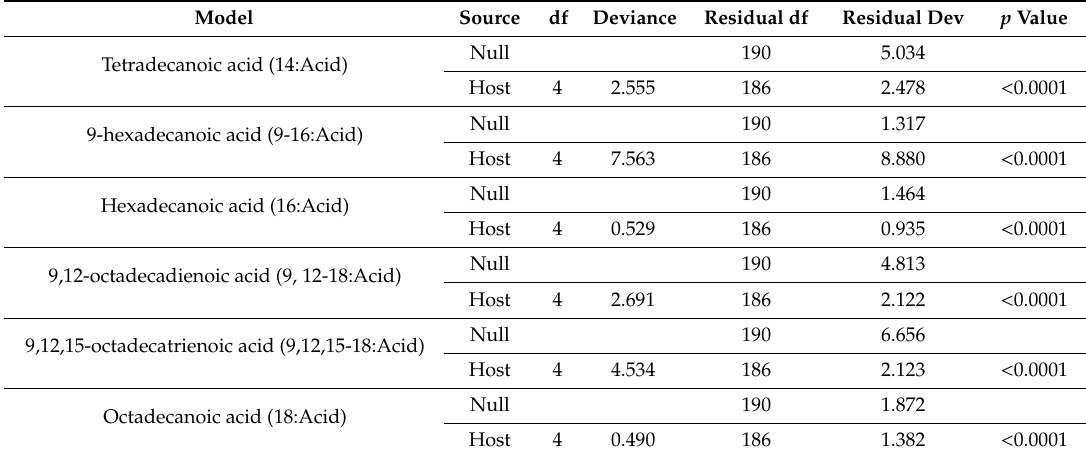
Table 1. Analysis of deviance tables for generalized linear models for proportions of total fatty acids represented by individual fatty acids for Drosophila suzukii reared from di ff erent